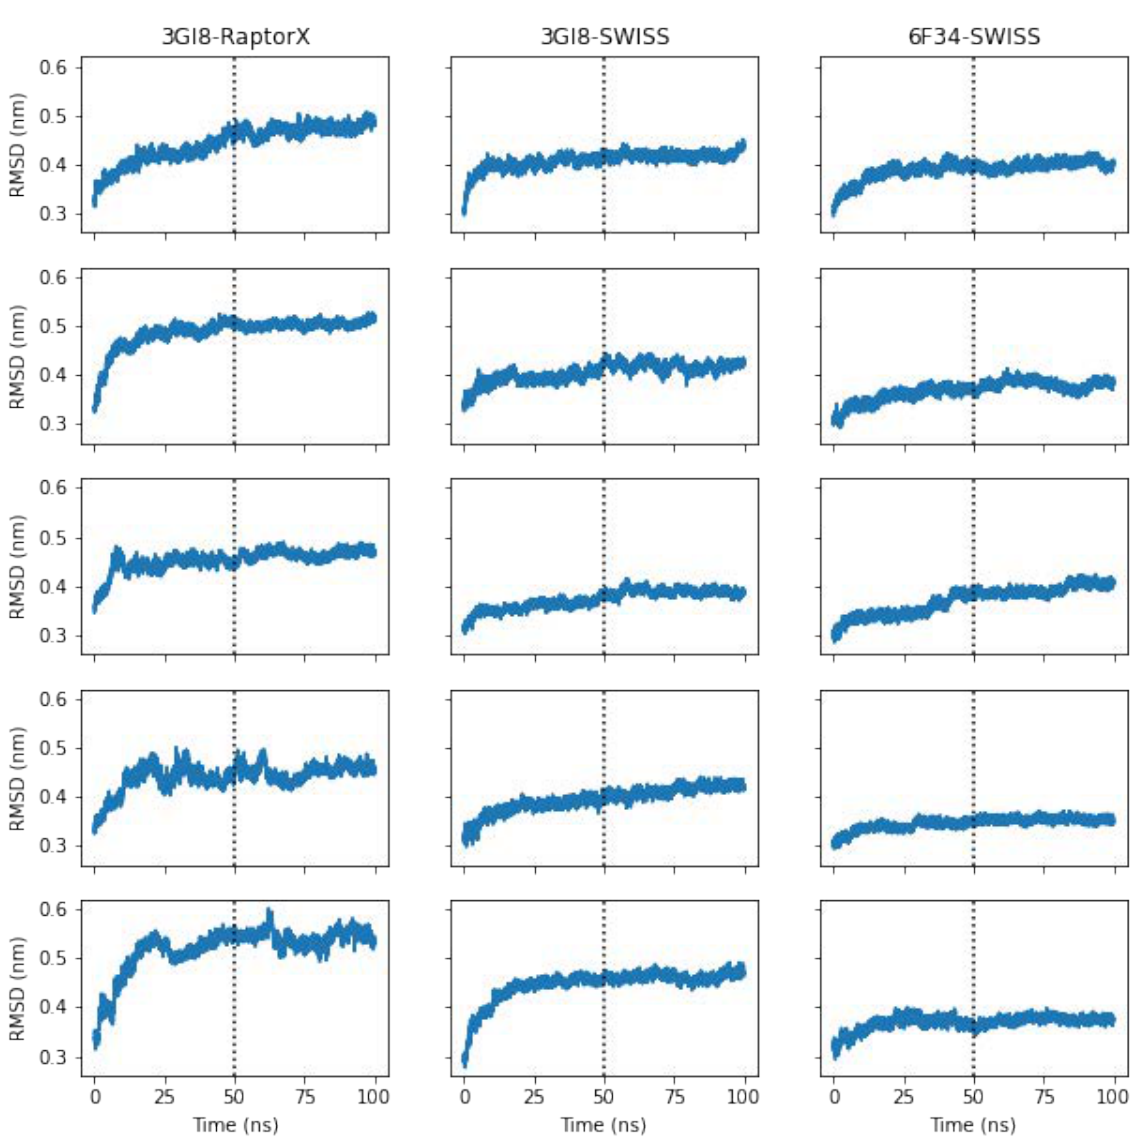
Figure A1. RMSD graphs of 3GI8-Raptorx and 3GI8-SWISS, 6F34-SWISS. This figure shows the RMSD graphs for each run of the three models. RMSD is displayed in nm and time is shown in ns. Most flexibility is observed in the first 50 ns of the